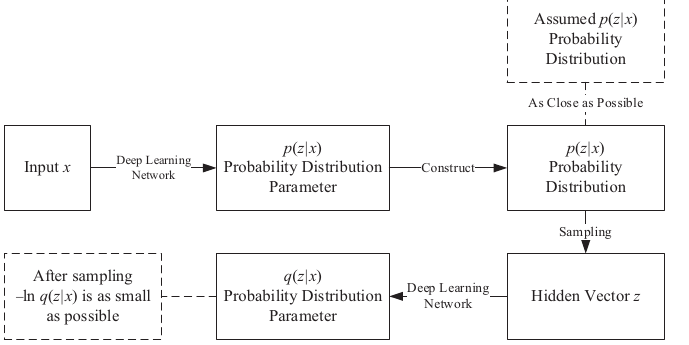
Figure 1. Use of deep learning to construct variational